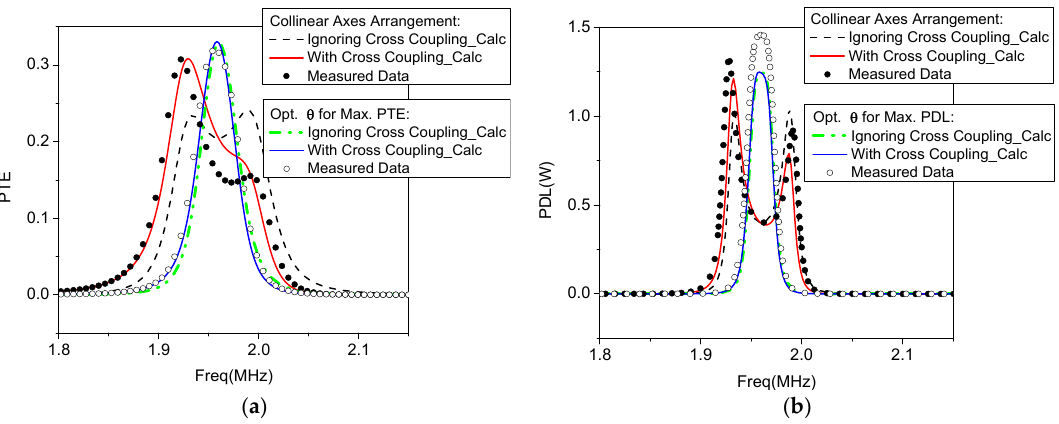
Figure 12. ( a ) Measured and theoretical PTE of collinear axes arrangement scenario and maximizing PTE by optimizing θ at D TI = 0.45 m when transfer distance D TR = 0.7 m; ( b ) Measured and theoretical PDL of collinear axes arrangement scenario and maximizing PDL by optimizing θ at D TI = 0.3 m when transfer distance D TR = 0.7 m.